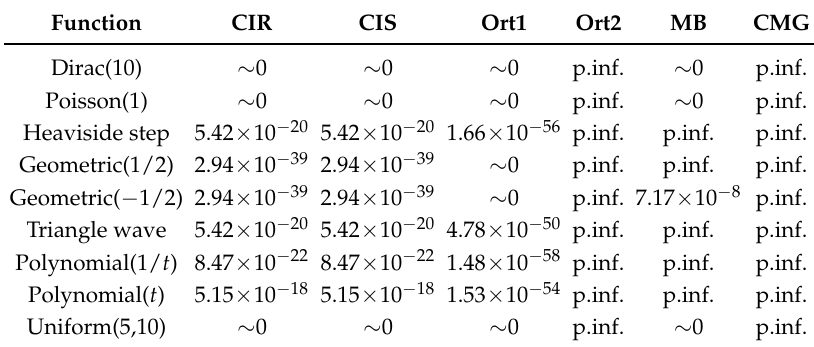
Table 3. Errors for various test functions ( N = 64, T max = 32, a = 2).